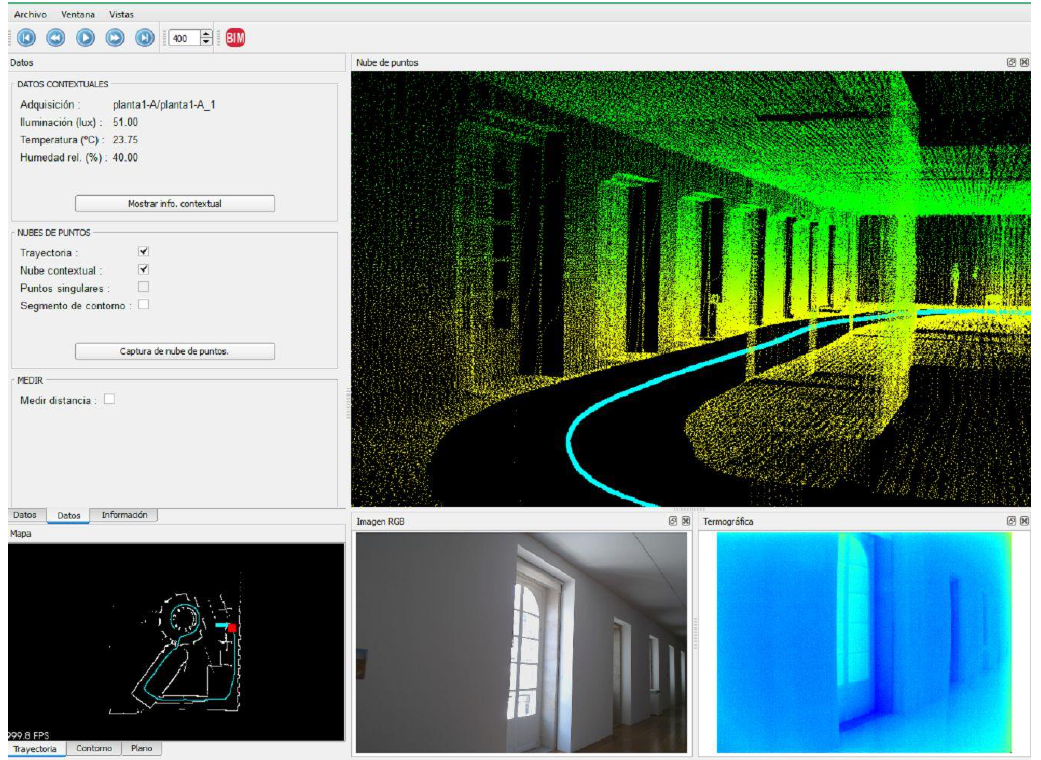
Figure 6. Software interface for virtual immersive navigation and ex situ data analysis.